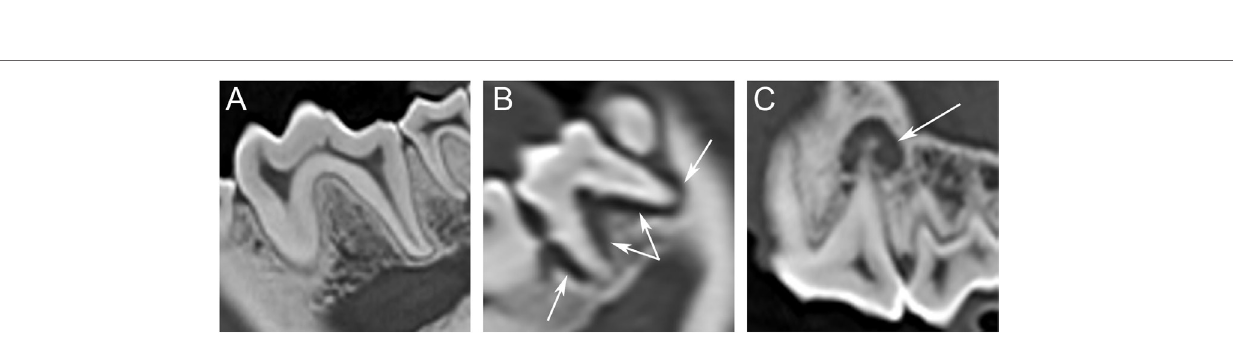
FigUre 2 | computed tomography (cT): (a) periodontitis and endodontic disease absent in a 4-year-old male-castrated labrador retriever in tooth 309 and 310, (B) periodontitis present in a 14-year-old male Dachshund in tooth 310, and (c) endodontic disease present in a 4-year-old male-castrated labrador retriever in tooth 208